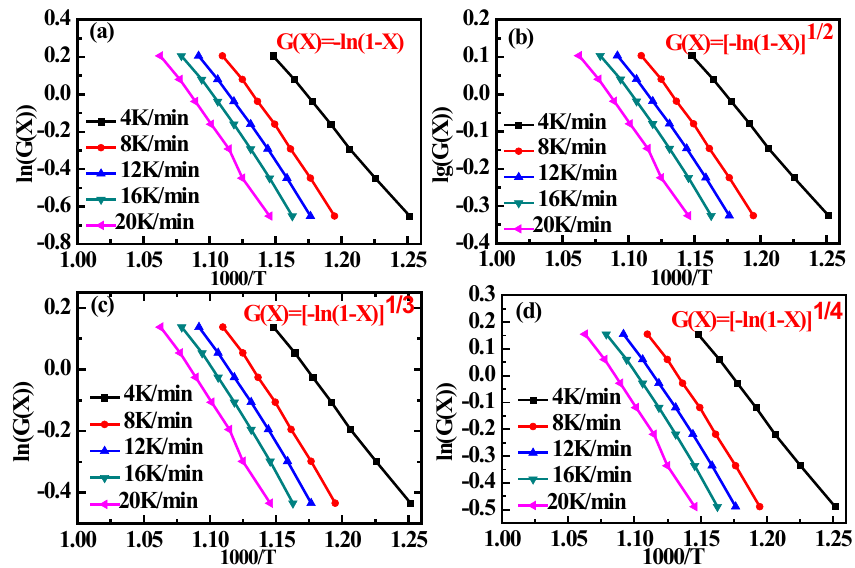
Figure 3. Plots of Equation (5) with G ( X ) given by the different kinetic models in the form [−ln(1 − X )] α for X values in the range of 0.2–0.8: ( a ) 1D Avrami–Erofeev model ( α = 1); ( b ) 2D Avrami–Erofeev model ( α = 1/2); ( c ) 3D Avrami–Erofeev model ( α = 1/3); ( d ) 4D Avrami–Erofeev model ( α = 1/4). Table 5. Activation energies E a and average E a values E ave of the steam gasification reaction of char obtained using the various Avrami–Erofeev models at different heating rates β (K·min −1 ). The E ave value obtained using the Starink method is also given as E Starink .